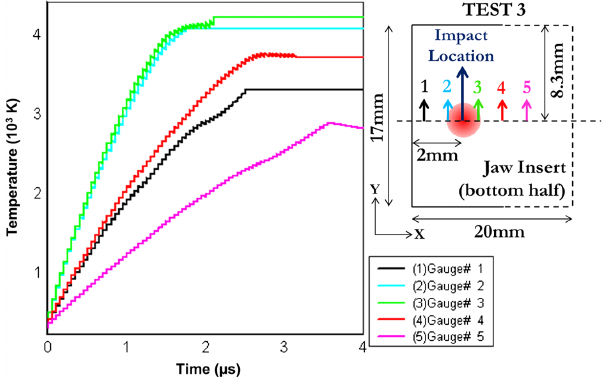
FIG. 15. TemperatureprofilesovertimeforTest3atfivedifferent gauges placed at the most loaded longitudinal section. The gauges are located at thevertical position of the impact, as indicated on the cross-sectional schematic diagram of the bottom half of the jaw insert. Gauge 1 is at 0.5 mm from the external surface, Gauge 2 is 1 mm distant from Gauge 1, Gauge 3 is 1 mm from Gauge 2, and so on for Gauge 4 and Gauge 5.